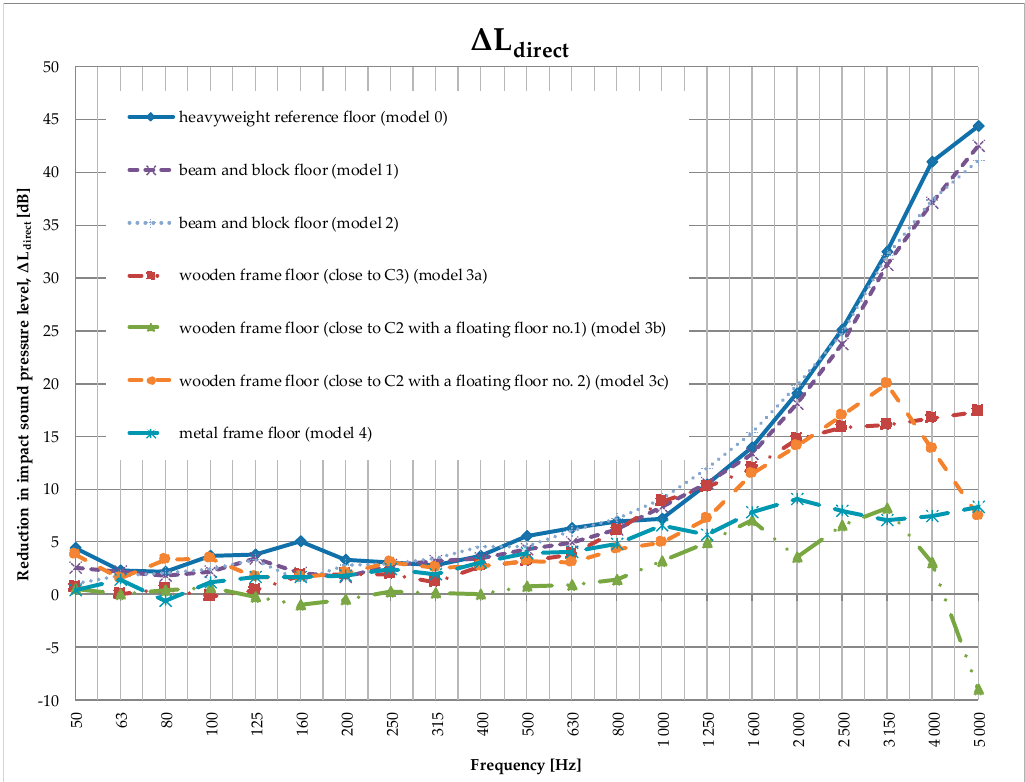
Figure 5. Dependence of reduction in impact sound pressure level, ∆ L direct , on frequency by an investigated floor covering tested on all considered floors.